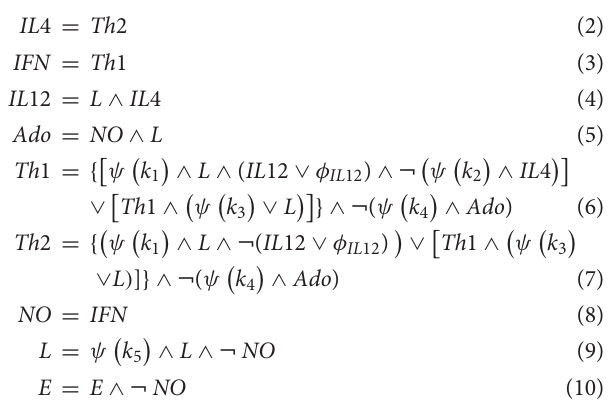
represents an “OR” logical operator, the symbol “ ∧ ” represents an “AND,” while “ ¬ ”